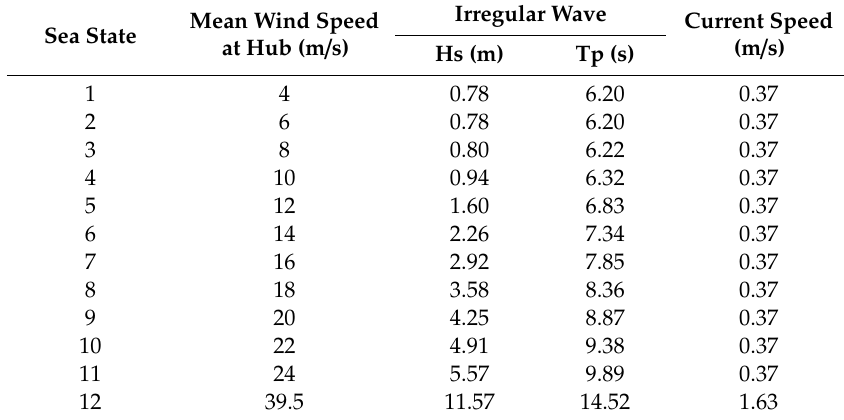
Table 4. Environmental conditions.